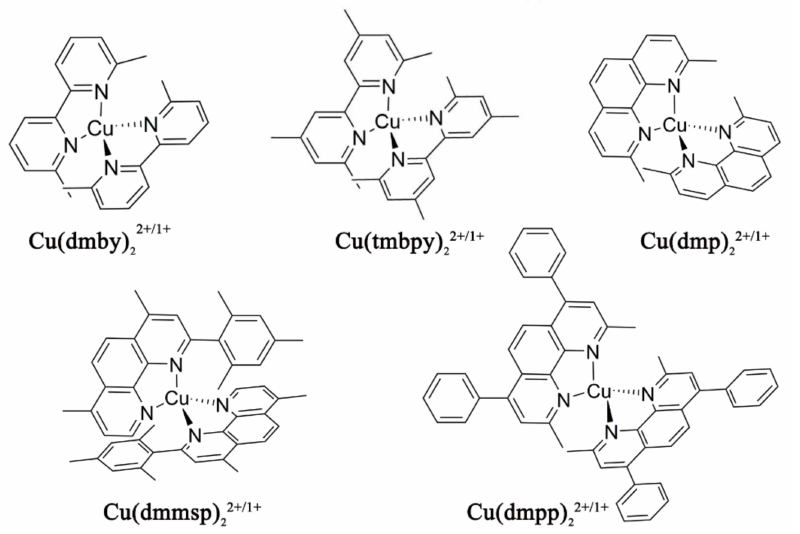
Figure 8. Molecular structures of Cu complexes studied as redox mediators in references [67–69]. Record PCE of 28.9% under indoor conditions (1000 lux irradiance) and 11.3% in a standard AM1.5G sunlight were achieved by Freitag et al. using a Cu(II/I) redox mediator and electrochemically deposited PEDOT films as counter electrodes